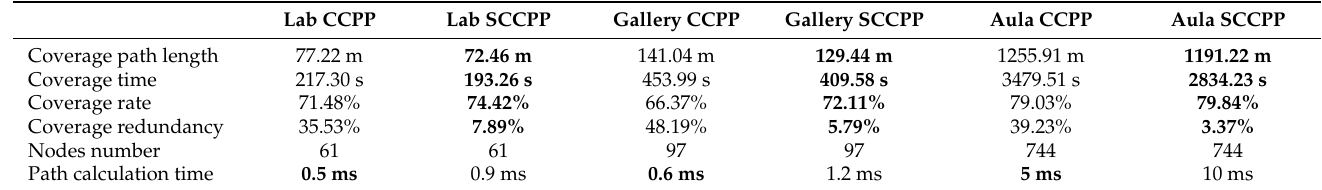
Table 1. Table of comparison of CCPP and SCCPP